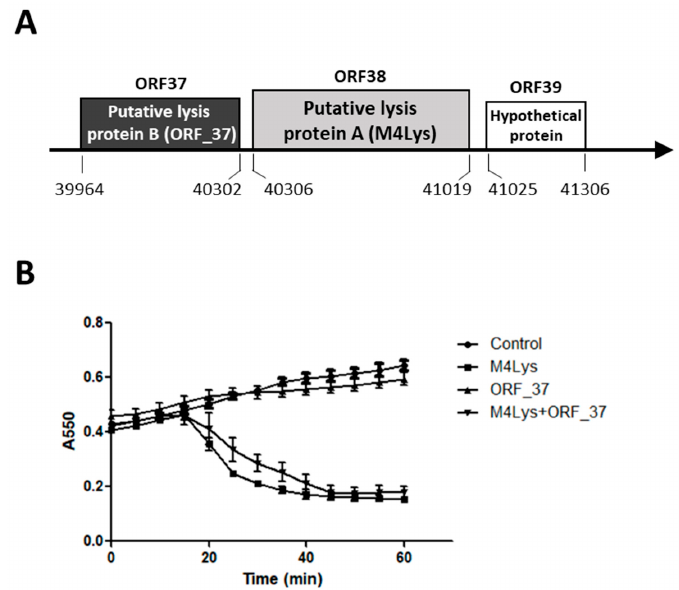
Figure 1. Schematic representation of the phage BSPM4 lysis cassette and analysis of the lysis kinetics by its putative lysis proteins. ( A ) Schematic representation of the phage BSPM4 lysis cassette; ( B ) Growth kinetics of the E. coli strains producing the putative lysis protein A (M4Lys) and the putative lysis protein B (ORF_37). Closed circles, empty vector; closed triangles, production of ORF_37; closed squares, production of M4Lys; reverse closed triangles, co-production of ORF_37 and M4Lys. Lysis activity of each gene was investigated by 0.1 mM IPTG induction and the turbidity of the cells was observed. Experiments for the growth kinetics were performed in triplicate. The results of each treatment are represented by the mean ± standard deviation.